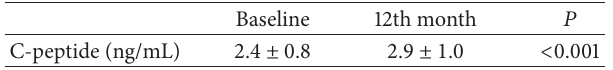
Table 3: Comparison of C-peptide levels in the baseline and twelfth